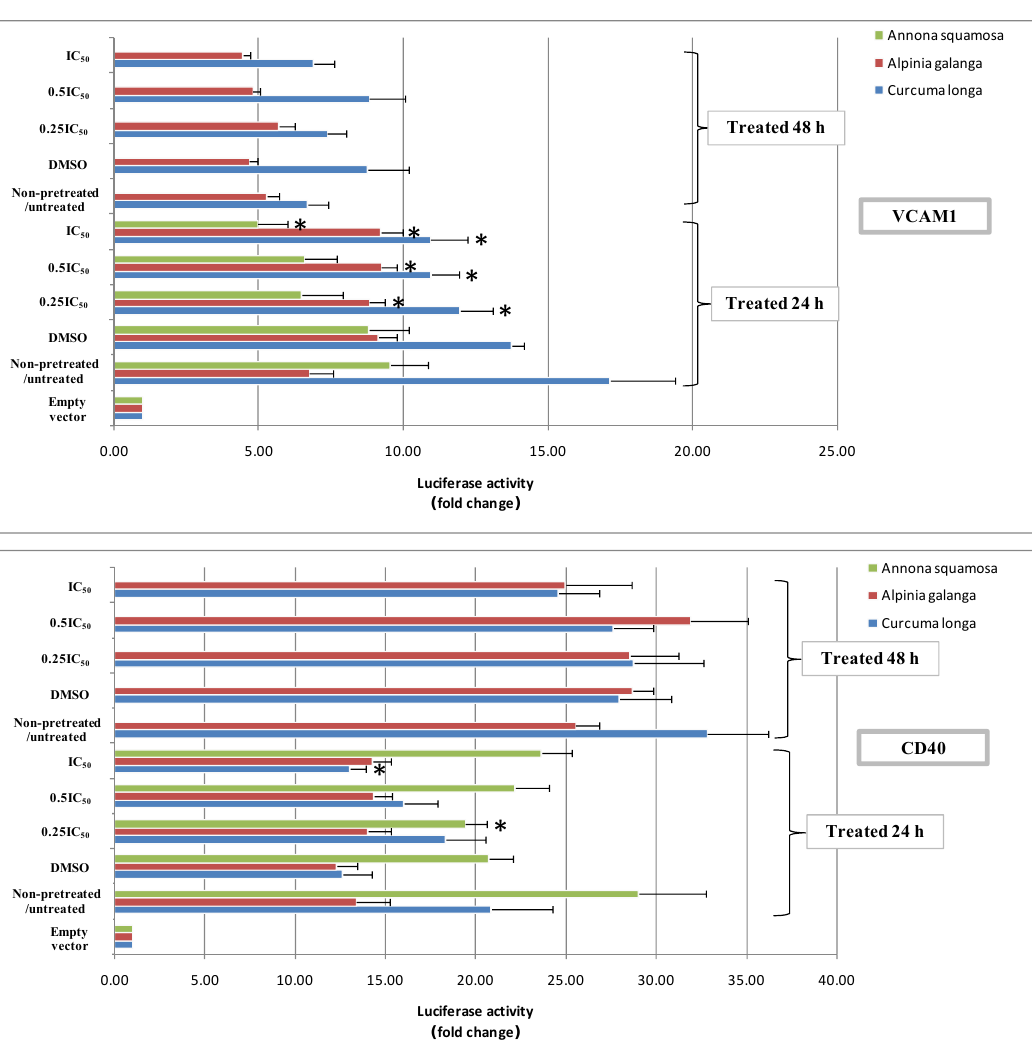
Figure 5. The effect of Thai medicinal herb extracts on promoter activity of NF- κ B signaling network genes in proinflammatory cytokines-non-pretreated HaCaT cells treated with increasing concentrations of each herbal extract type for either 24 h or 48